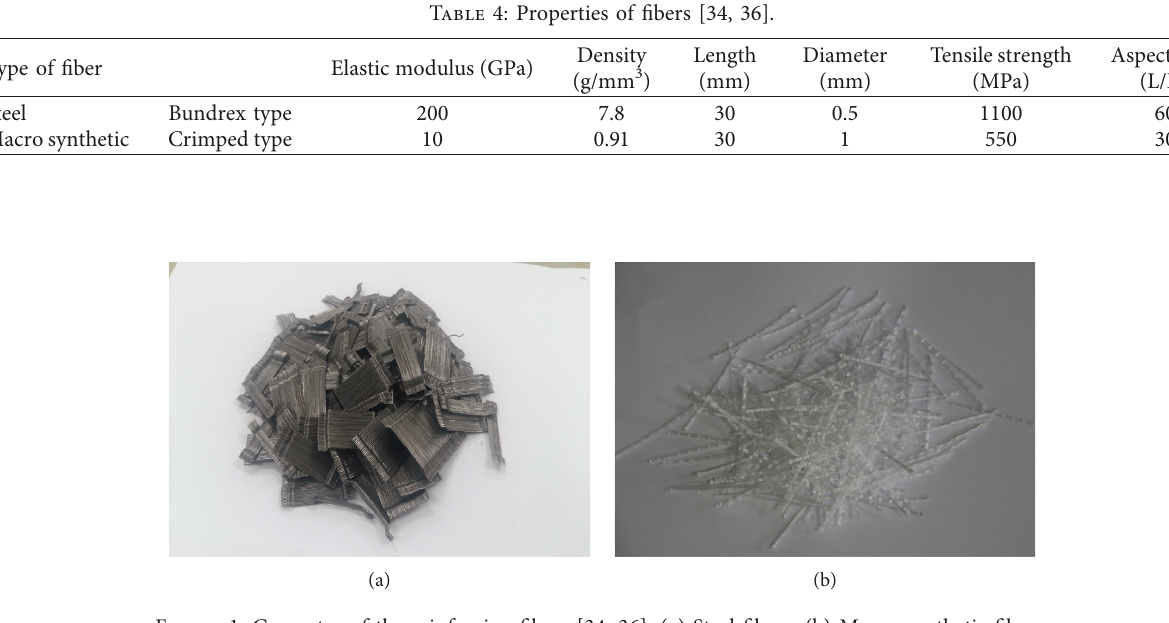
Figure 1: Geometry of the reinforcing fibers [34, 36]. (a) Steel fibers. (b) Macro synthetic fibers. Table 5: Properties of SB latex [34–36].